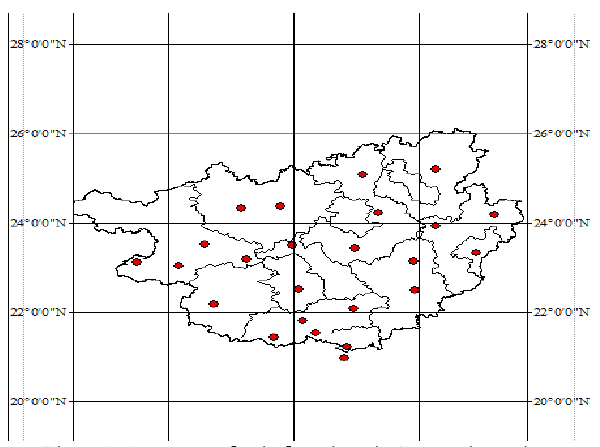
Figure 3. 24 meteorological stations in Guangxi Province